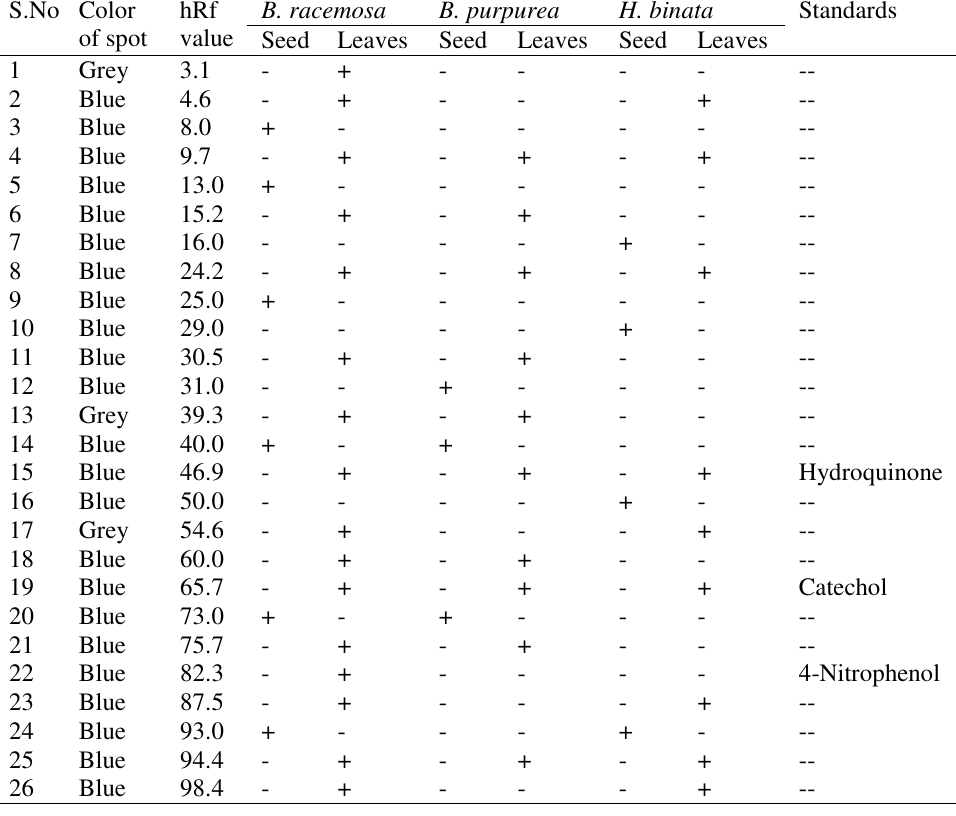
Table-7 . Qualitative separation of flavonoids S.No Color of spot hRf Fluorescent yellow Fluorescent blue Fluorescent blue Fluorescent blue Fluorescent blue Fluorescent blue Fluorescent blue Fluorescent blue Deep fluorescent blue Fluorescent